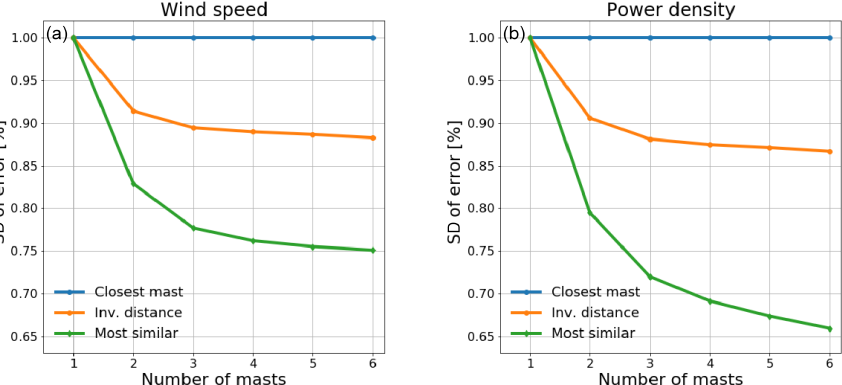
Figure 6. Reduction of the standard deviation of wind speed (a) and power density (b) error as function of predictor masts when using inverse-distance weighting and the most similar predictor compared to closest